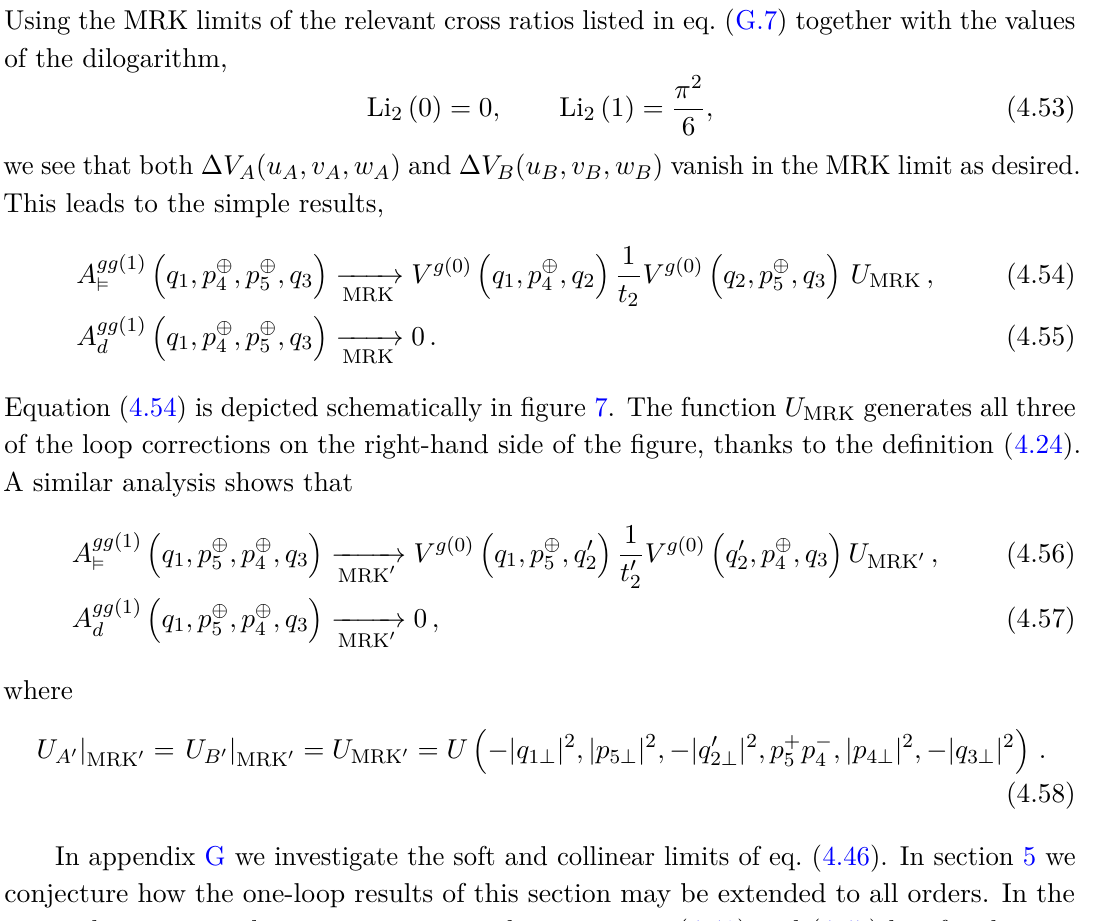
Figure 7 . Schematic illustration of the further factorisation of the one-loop two-gluon CEV for the ordering σ in the MRK A